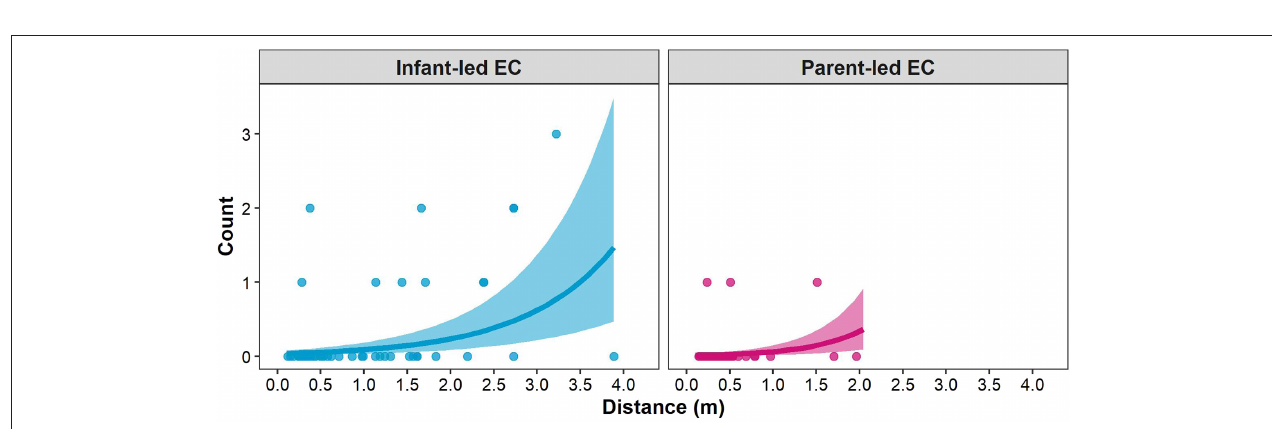
FIGURE 3 | Relationship between the proportion of infant’s walking time and the posterior mean of the interpersonal distance (log transformed) at the time of infant-led EC bouts (left) and parent-led EC bouts (right) . Each dot represents one observation day. The color of the dots represents each infant-parent dyad.